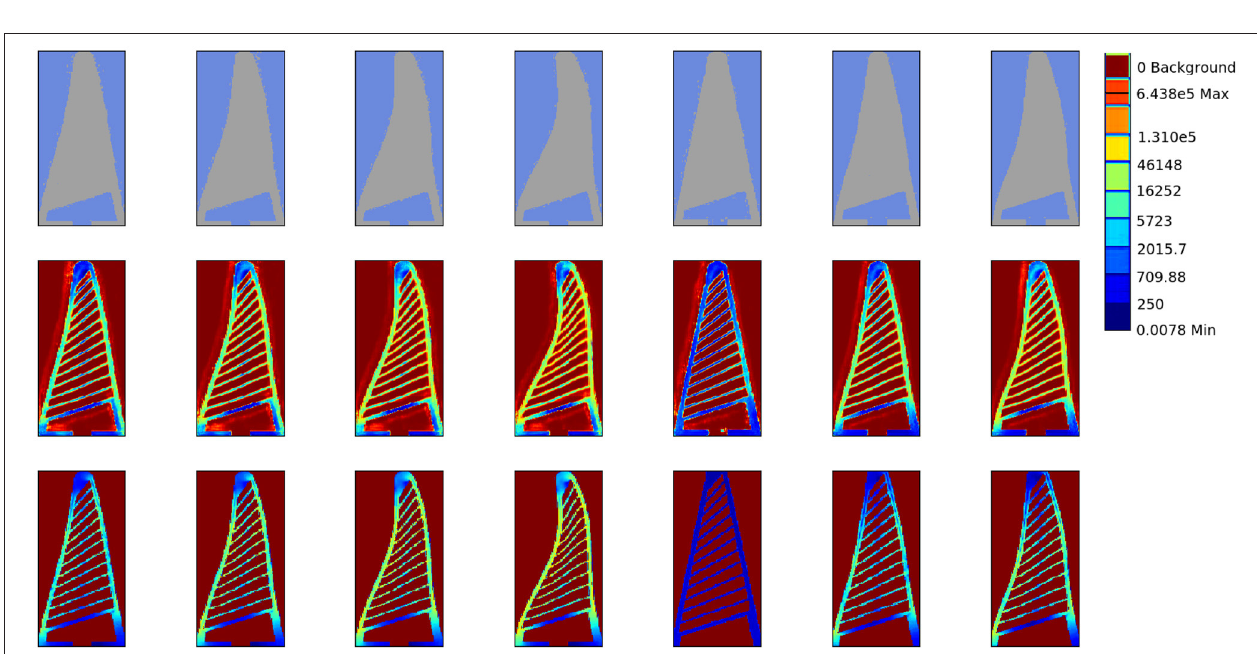
FIGURE 8 | Evaluating material generalisation. (Top-left) We additionally evaluate our approach on a ring shaped object made of rubber and steel material having trained only on steel objects (square and cylinder). Note the difference in the stress profile generated by a rubber ring as compared to other material. However, the deformation of the Fin Ray finger is very less in rubber. This confirms our hypothesis that the deformation image indeed captures stress on the gripper. (Top-right) Force prediction by our approach as compared to the true fore obtained by the FEA on materials the three materials, which showcases the efficacy of our approach. (Bottom) The effect of different material less to the force prediction as the deformation image captures most of the force information. Note that the time taken by FEA to simulate the soft materials significantly large on the other hand, for the learning based approach remains unaffected with the material. This showcases the effectiveness of data driven approaches as surrogate for numerical simulation approaches.